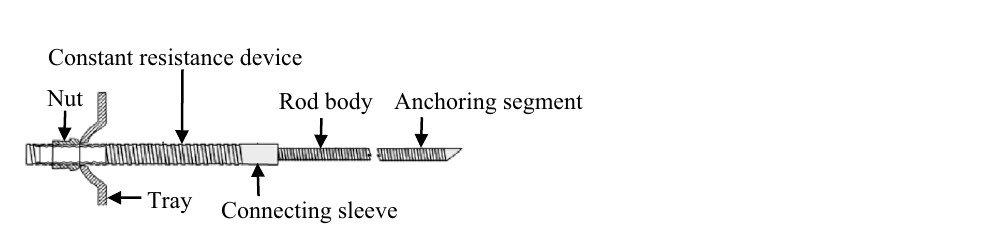
Figure 3. Structure of constant resistance